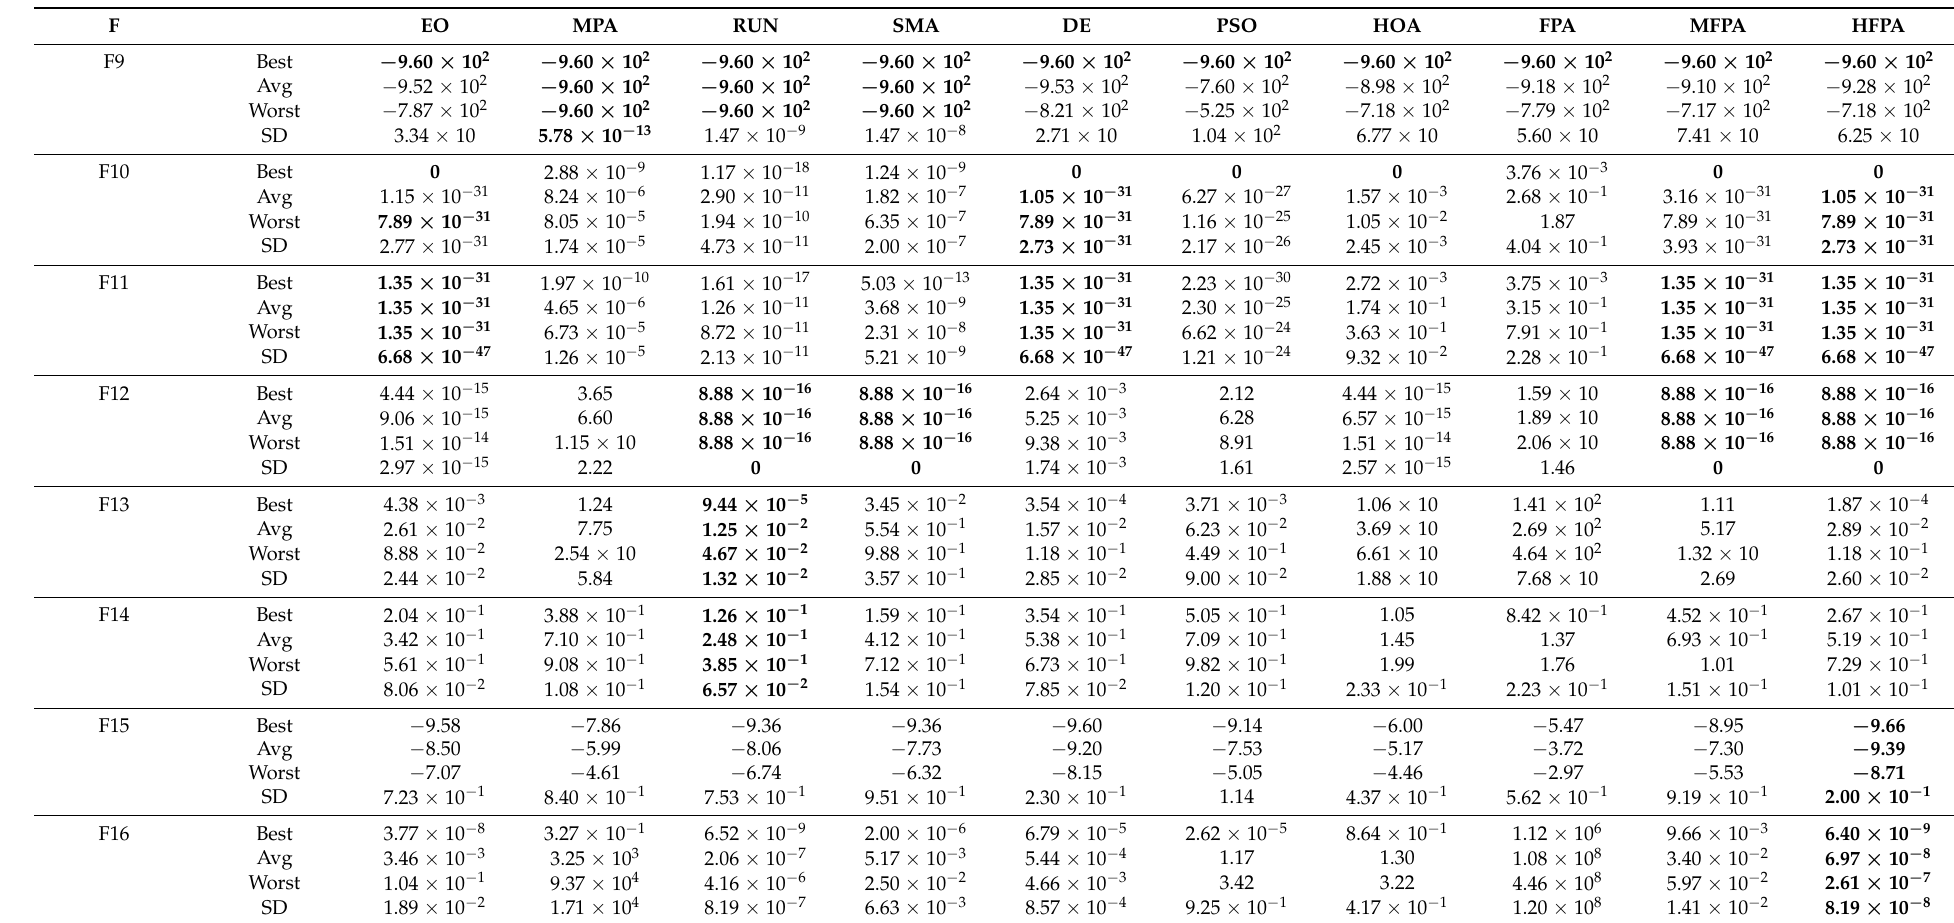
Table 4. Comparison under the multimodal mathematical test